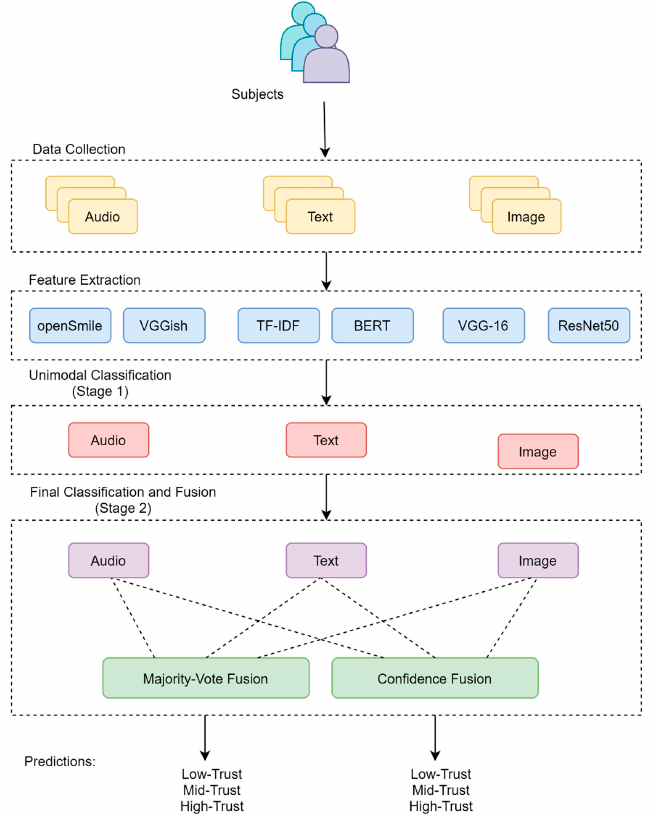
Figure 1. Experimental framework: Stage 1—Unimodal Classification; Stage 2—Final Classification and Fusion (Multimodal) .